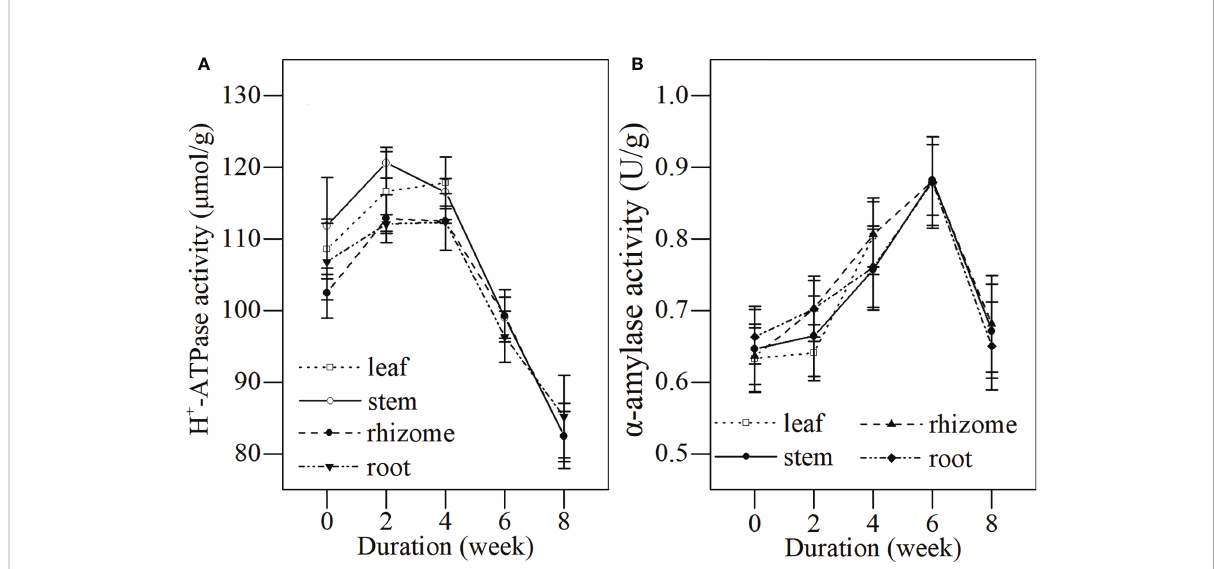
FIGURE 6 Dynamics of H + -ATPase and a -amylase activity in different tissues of L. japonica during the senescence stage. Data are presented as mean ± SE. Each batch consisted of fi ve replicates, which had two repetitions in parallel. (A) H + -ATPase activity, (B) a -amylase activity.